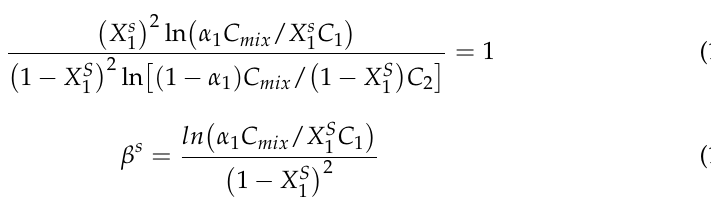
Table 4. Thermodynamic and interfacial properties of TCH + SDS/SLS mixtures in aqueous NaCl a . α 1 X s